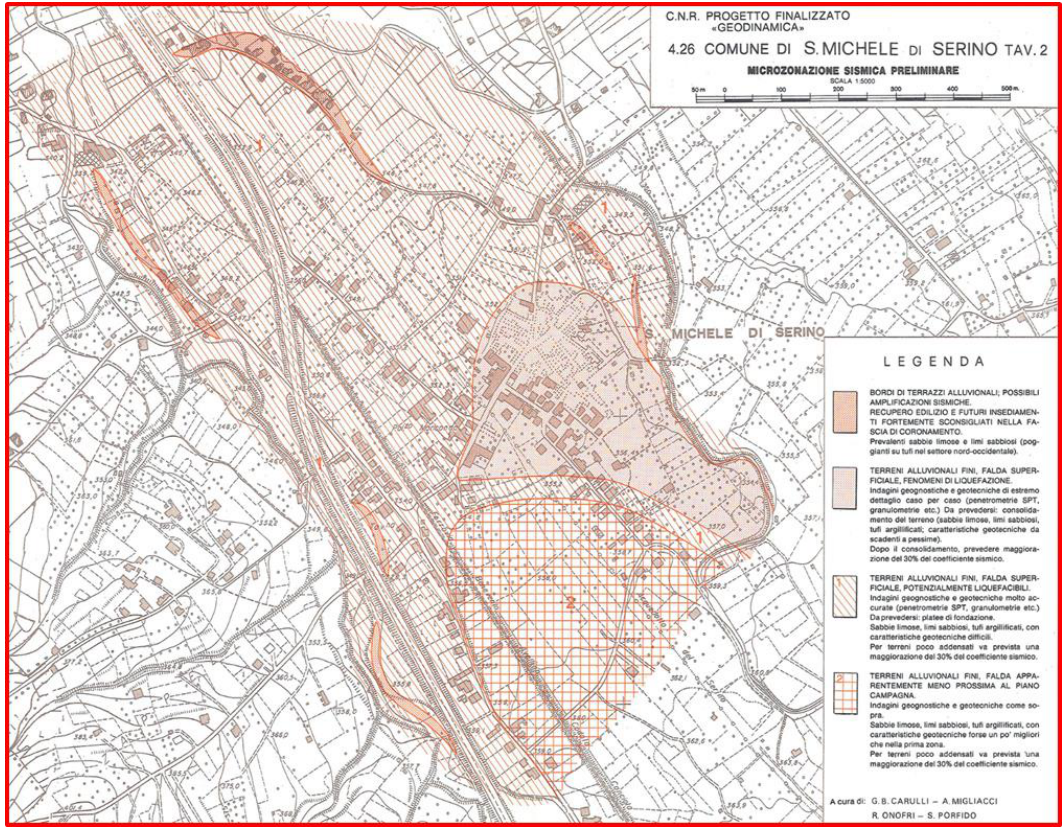
Figure 59. Original map of the seismic microzonation of San Michele di Serino according to [29].